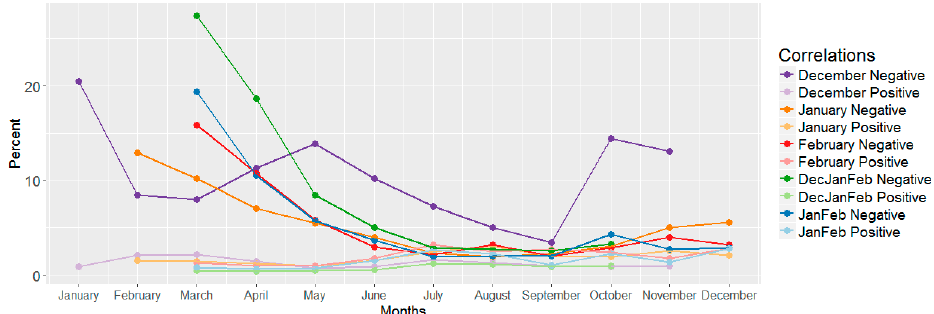
Figure 13. Percentages of negatively and positively correlating pixels of the December (violet), January (orange) and February (red), longer winter (green) and shorter winter (blue) SCD with the following monthly mean NDVIs.